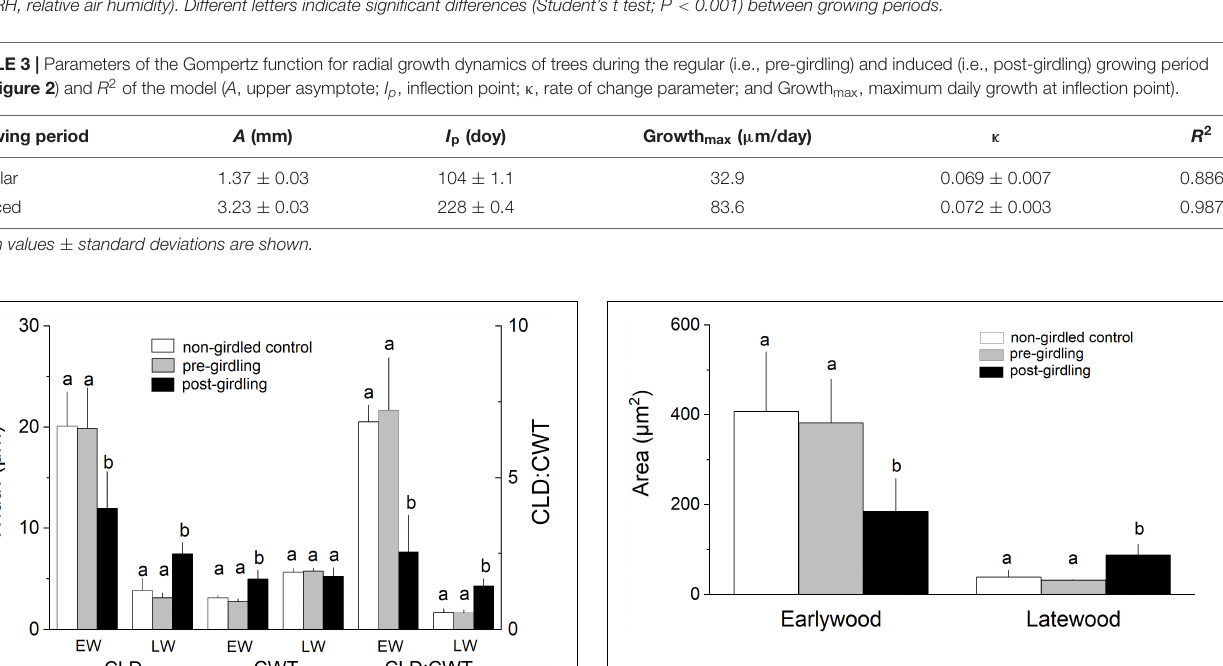
FIGURE 4 | Cell area of earlywood (EW) and latewood (LW) tracheids in non-girdled controls, and above the girdling zone during the regular (i.e., pre-girdling) and induced growing period (i.e., post-girdling). Student’s t test was applied to determine statistically significant differences of anatomical parameters between non-girdled controls and pre- and post-girdling. Different letters indicate significant difference at P <